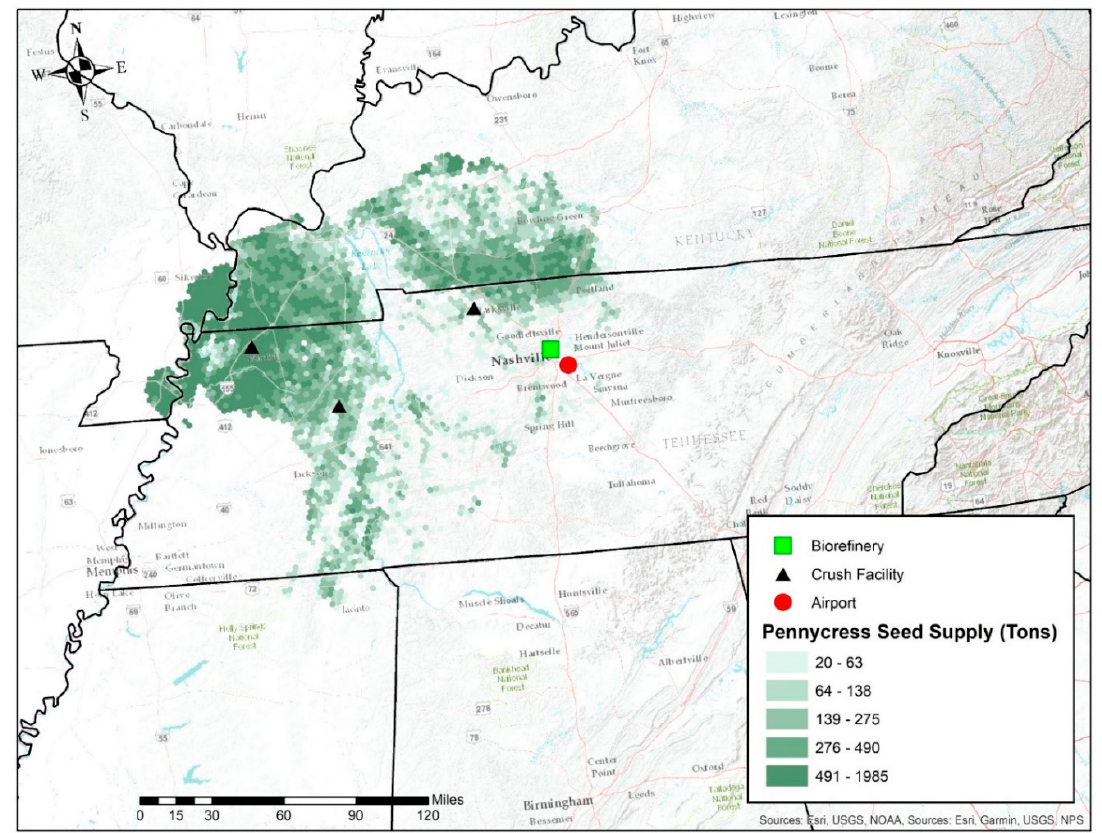
Figure 4. Field pennycress supply, oilseed crushing facility, and biorefinery locations for a sustainable jet fuel supply chain to serve the Nashville, Tennessee USA international airport.